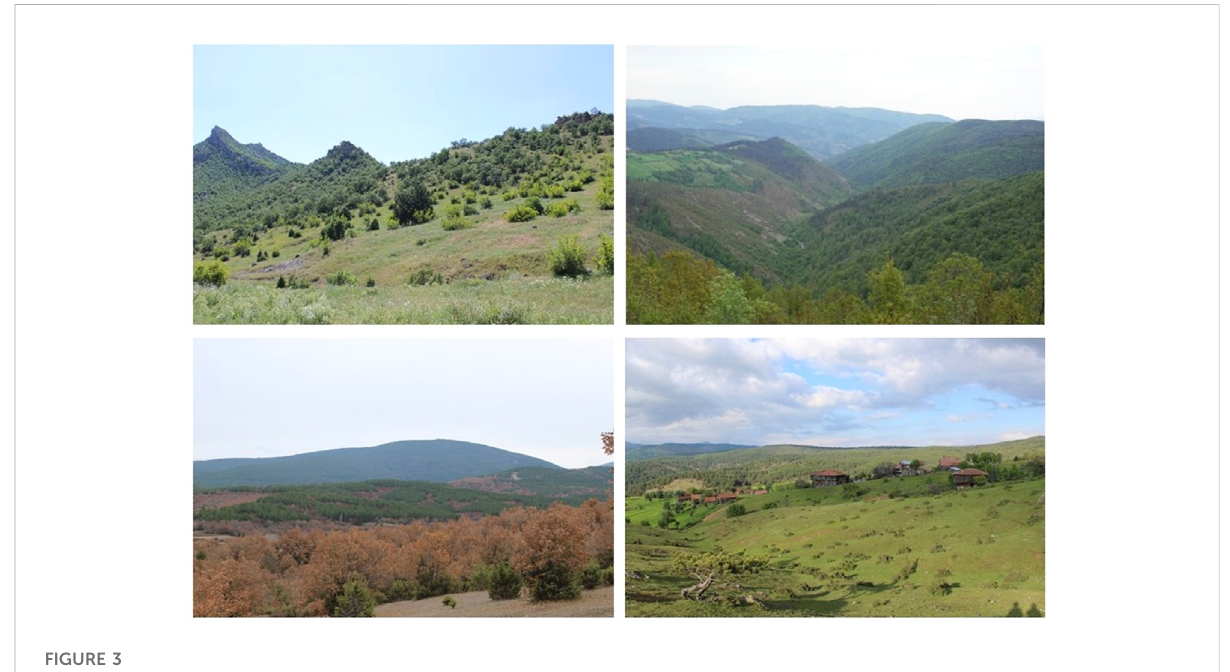
FIGURE 3 General views from the